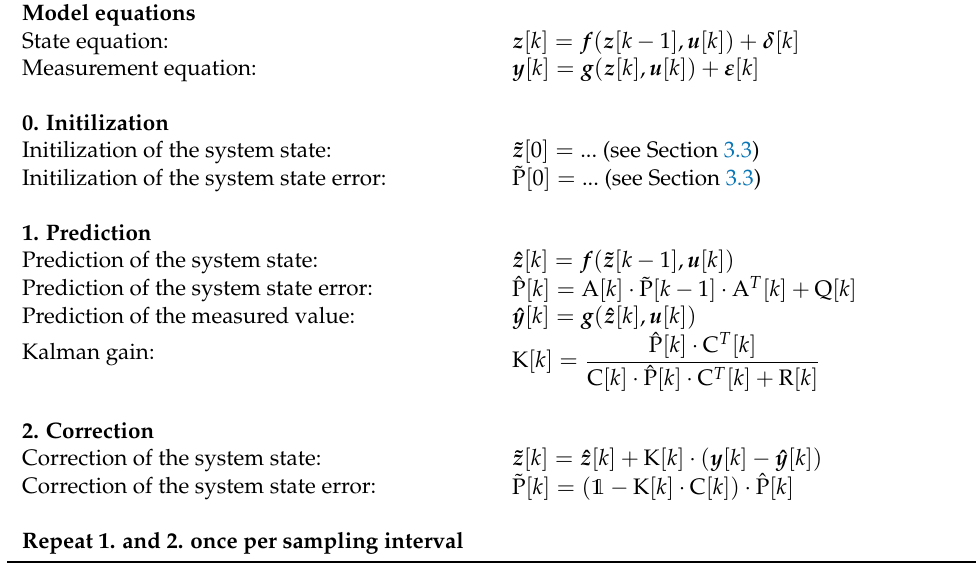
Table 1. Standard system and algorithm description of the extended Kalman filter.